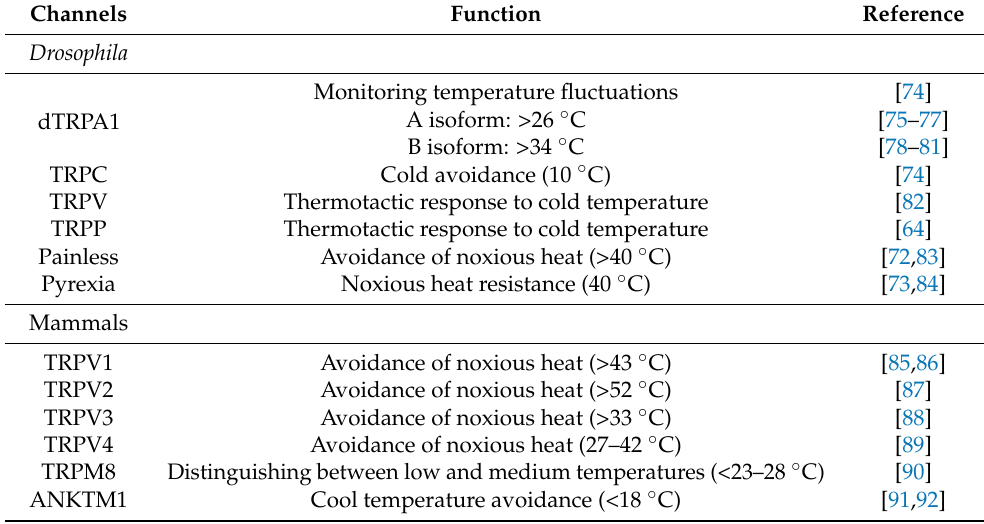
Table 1. Transient receptor potential channels in Drosophila and